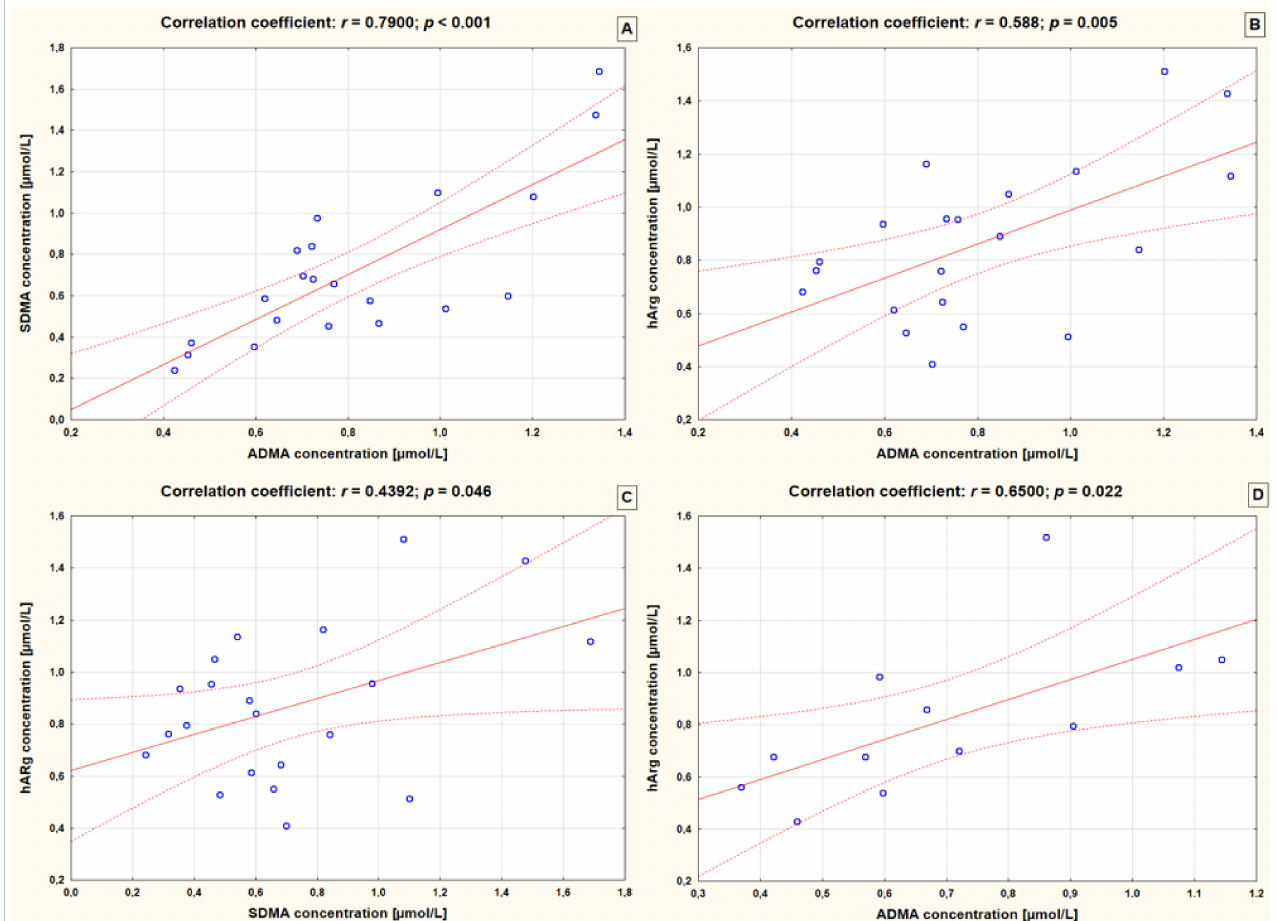
Figure 1. Significant correlations between arginine derivatives in controls ( A – C ) and epileptic children receiving 2 AEDs ( D ). ADMA—asymmetric dimethylarginine; SDMA—symmetric dimethylarginine; hArg—homoarginine; r—Pearson’s correlation